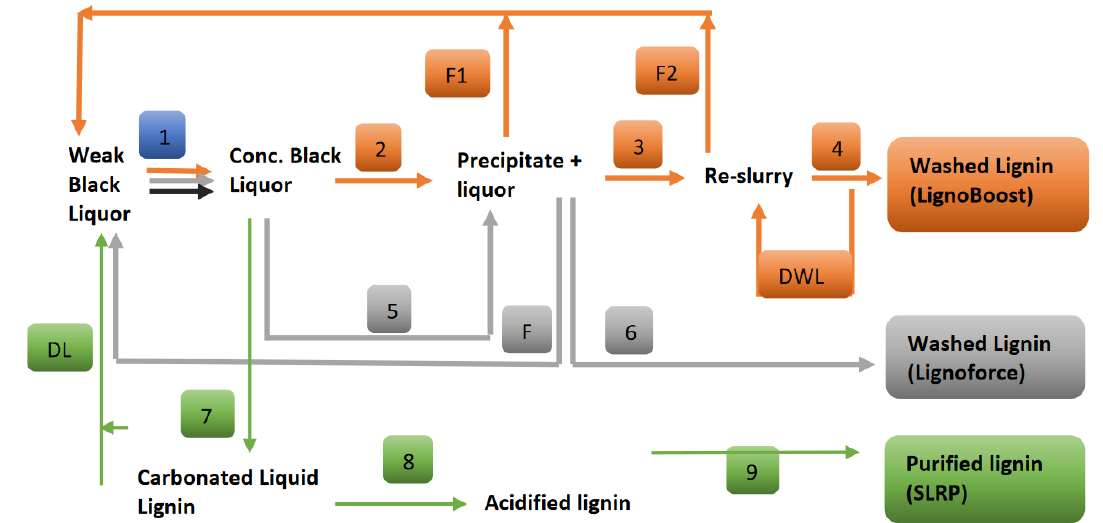
Figure 6. Representative diagram of lignin recovery by different processes. 1-evaporation and concentration: F, F1 and F2-filtrates; 2-pH adjustment to 9.5 using CO 2 and aging to flocculate followed by filtration; 3-Filtrate re-slurried to pH 2 using H 2 SO 4 ; 4-Filtration and washing using wash liquid (W.L.); DWL- Displacement wash liquor; 5-Oxidation using O 2 followed by acidification using CO 2 (pH10), coagulation and filtration; 6-Precipitate/lignin cake washing with dilute H 2 SO 4 ; 7-Carbonation using CO 2 and settling (pressurized); 8-Acidification using H 2 SO 4 and brine (pressurized); 9-Washing for ash removal (water); DL-depleted liquor.Arrows represent reaction steps (Orange-Lignoboost, Grey-Lignoforce, Green- SLRP).